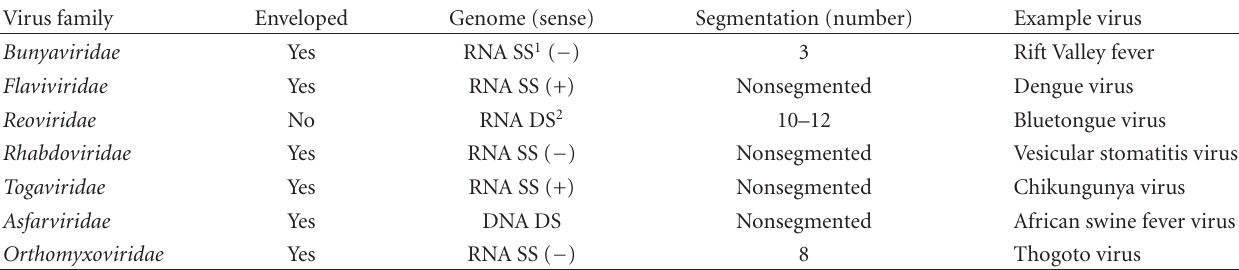
Table 1: Details of selected arbovirus